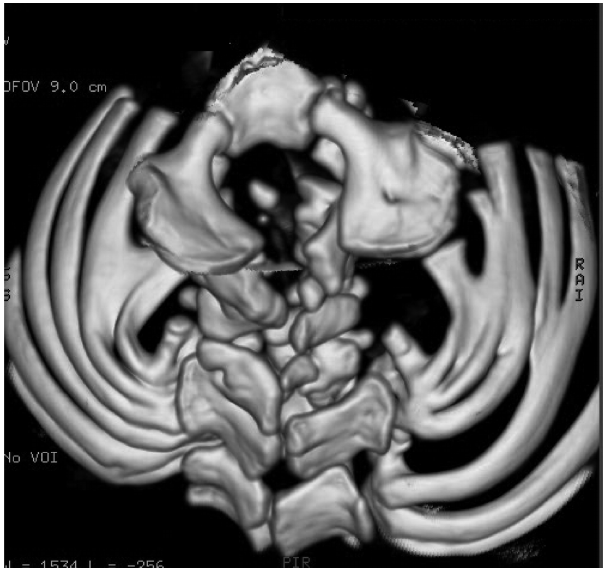
Figure 10 - A 3D reconstruction CT scan of a 9-year-old girl showed extensive failure of the fusion of the spinous processes of the lumbar vertebrae associated